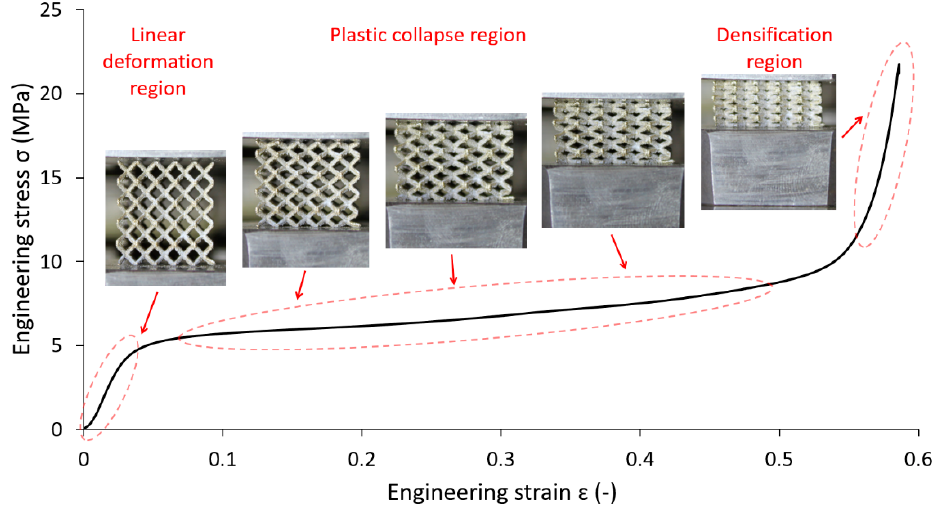
Figure 14. BCC lattice structure behavior in different regions of deformation.